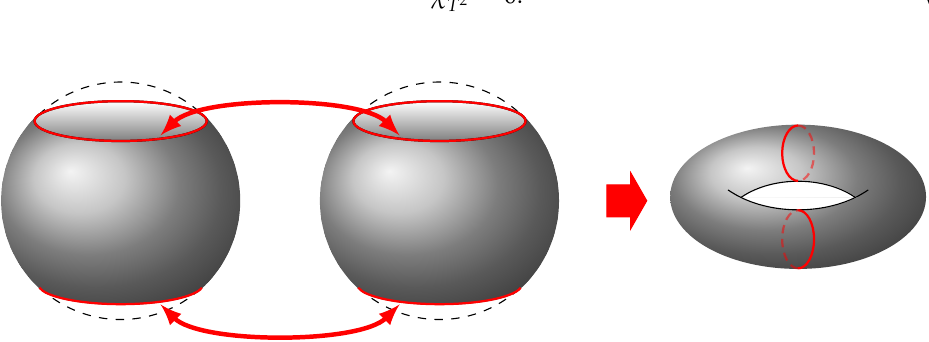
Figure 6. A torus is obtained by gluing two cylinders along the boundaries.